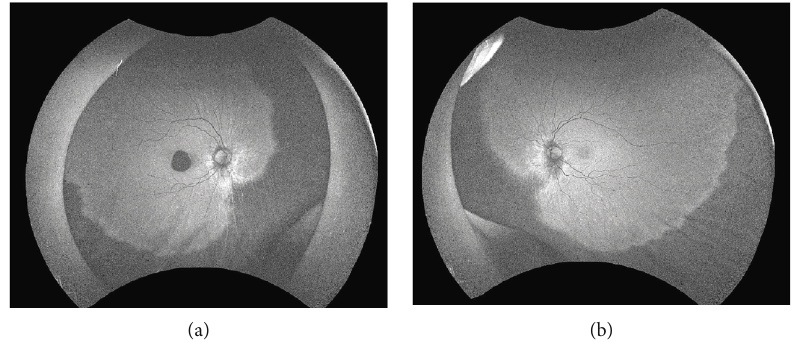
Figure 5: Right (a) and left (b) wide- fi eld fundus auto fl uorescence images. Note the hypoauto fl uorescent areas corresponding with a circumferential chorioretinal atrophy in the mid-peripheral and peripheral retina. Auto fl uorescence loss is detected in the macular area in the right eye.